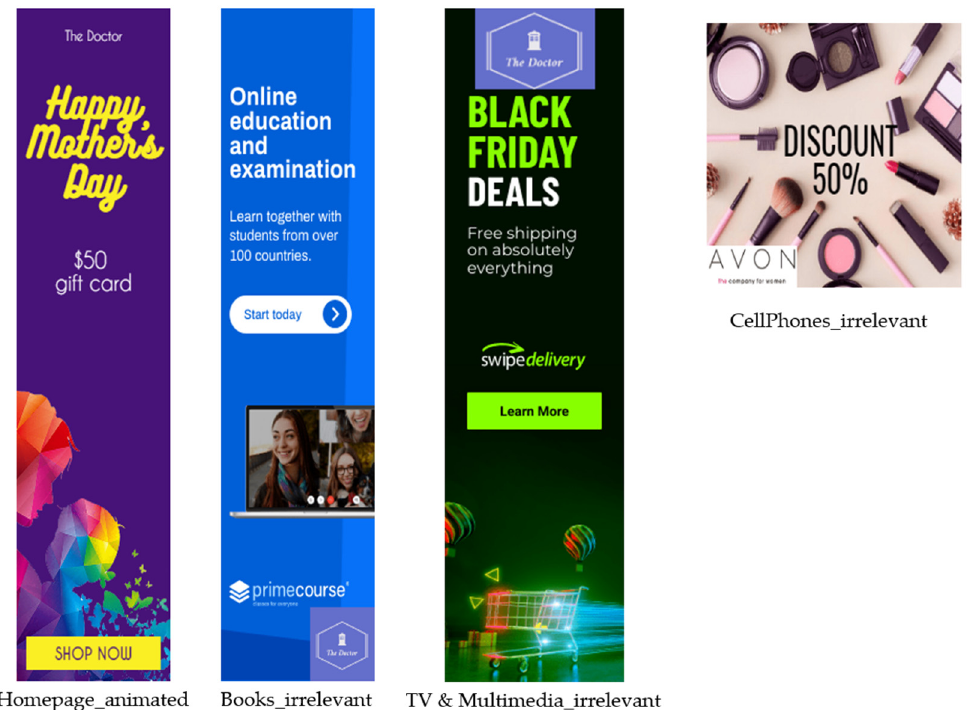
Figure 1. Constructed banner advertisements with irrelevant content and the category in which they were placed.